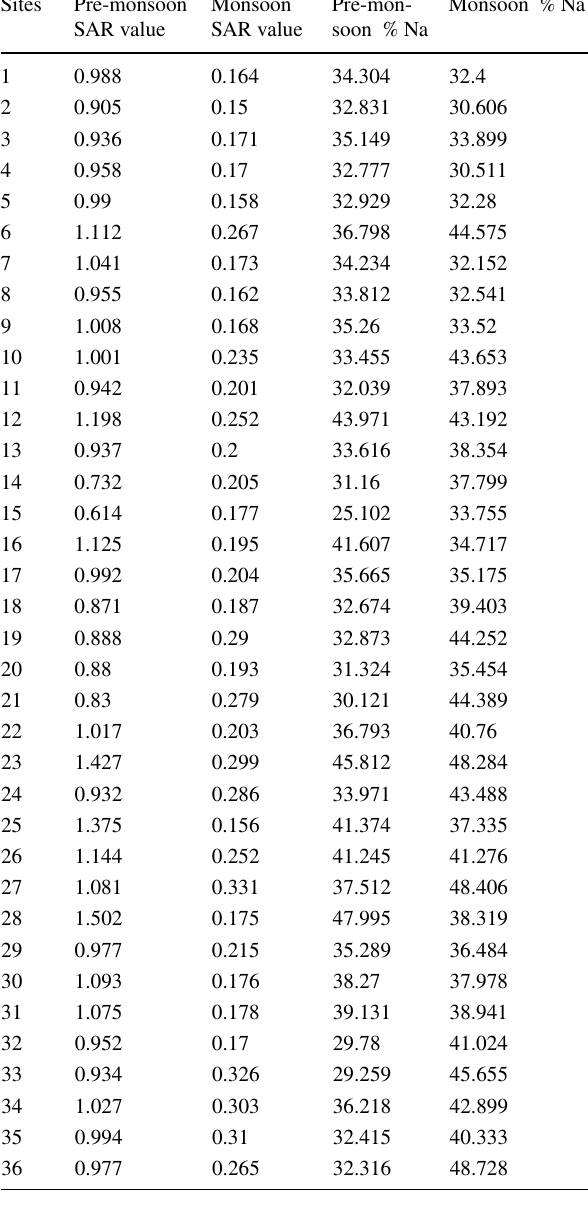
Table 8 Sodium adsorption ratio (SAR) and percent sodium (% Na + ) of the pre-monsoon and monsoon